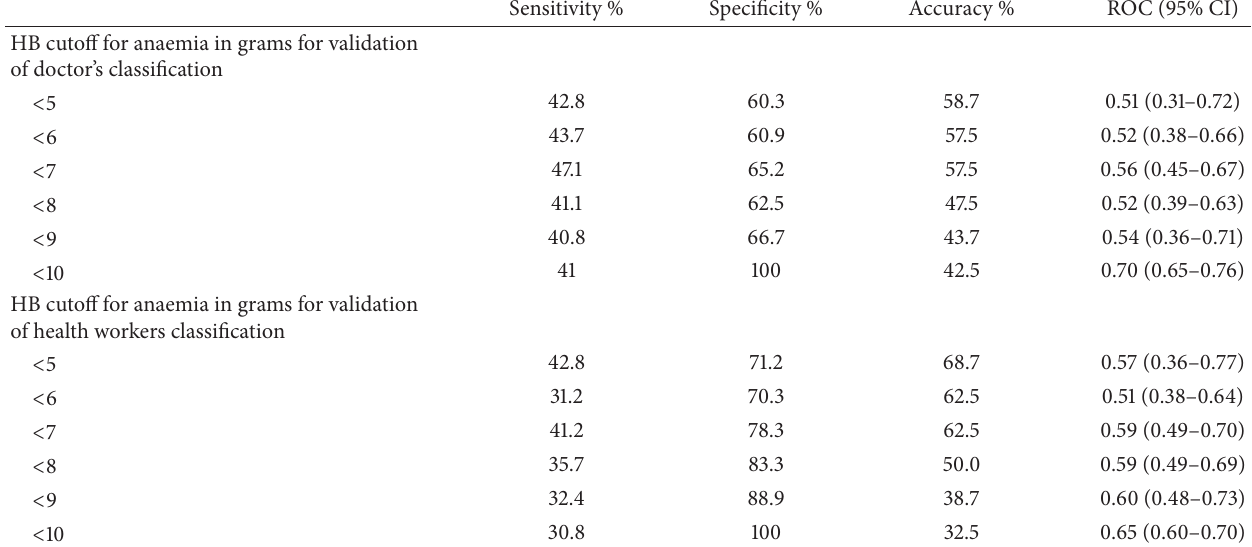
Table 1: Validity of doctor and health worker’s classification of palmar pallor against different haemoglobin cutoff